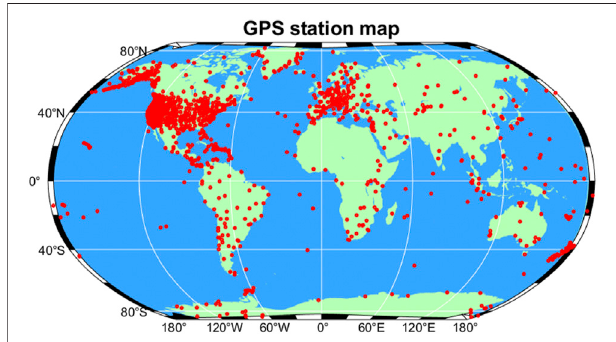
FIGURE 2 | Locations of 2,764 GPS stations. The stations in North America (the United States) are relatively closer than the stations elsewhere in the